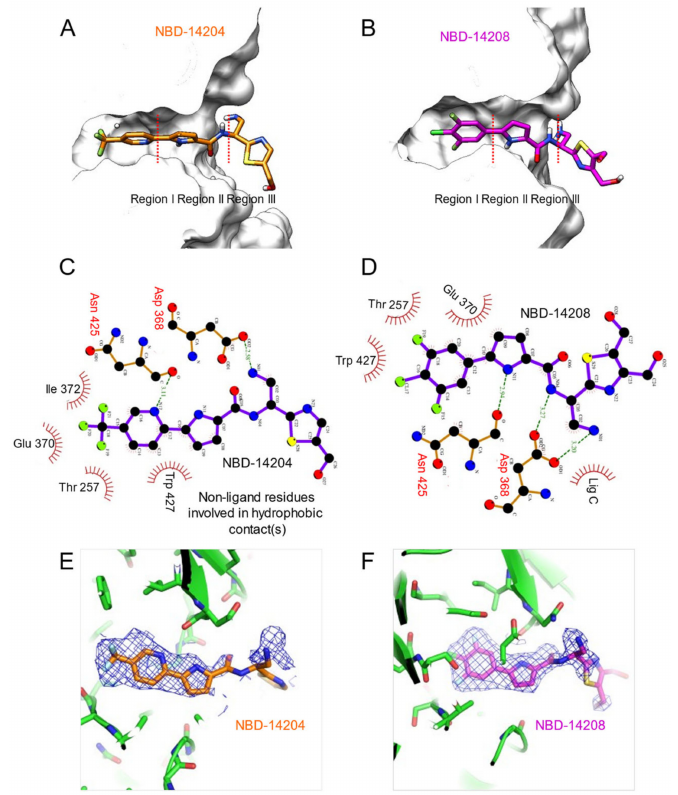
Figure 2. Crystal structures NBD-14204 and NBD-14208 in complex with gp120 core. ( A ) NBD-14204 in stick representation in the Phe43 cavity of gp120. ( B ) NBD-14208 in stick representation in the Phe43 cavity of gp120 (Regions I, II, and III are indicated in both structures. Detailed interactions of NBD-14204 ( C ) and NBD-14208 ( D ) with gp120. The dotted green lines represent the hydrogen bonds and their lengths ( C , D ). The 2Fo-Fc electron density map of NBD-14204 ( E ) and NBD-14208 ( F ) contoured at 1 σ